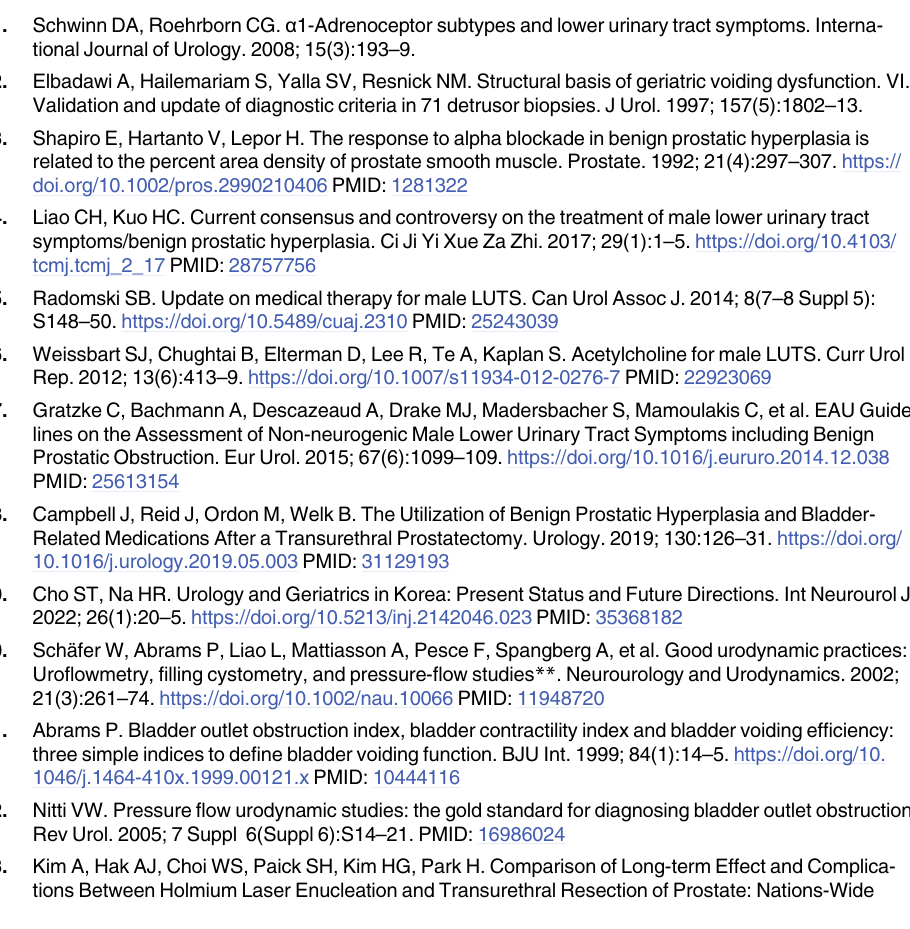
S4 Table. Statistic information for Table